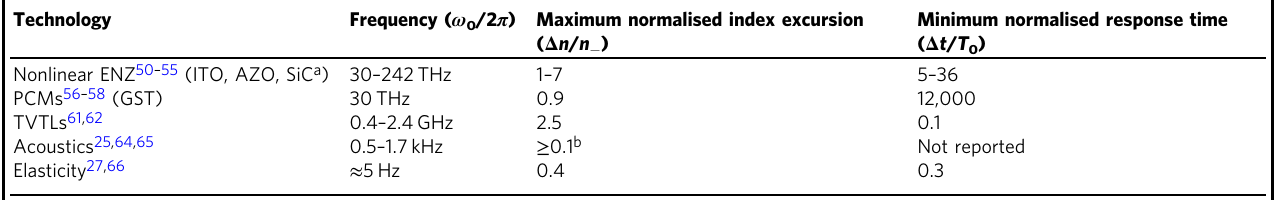
Table 1 Potential T-SUSY implementation